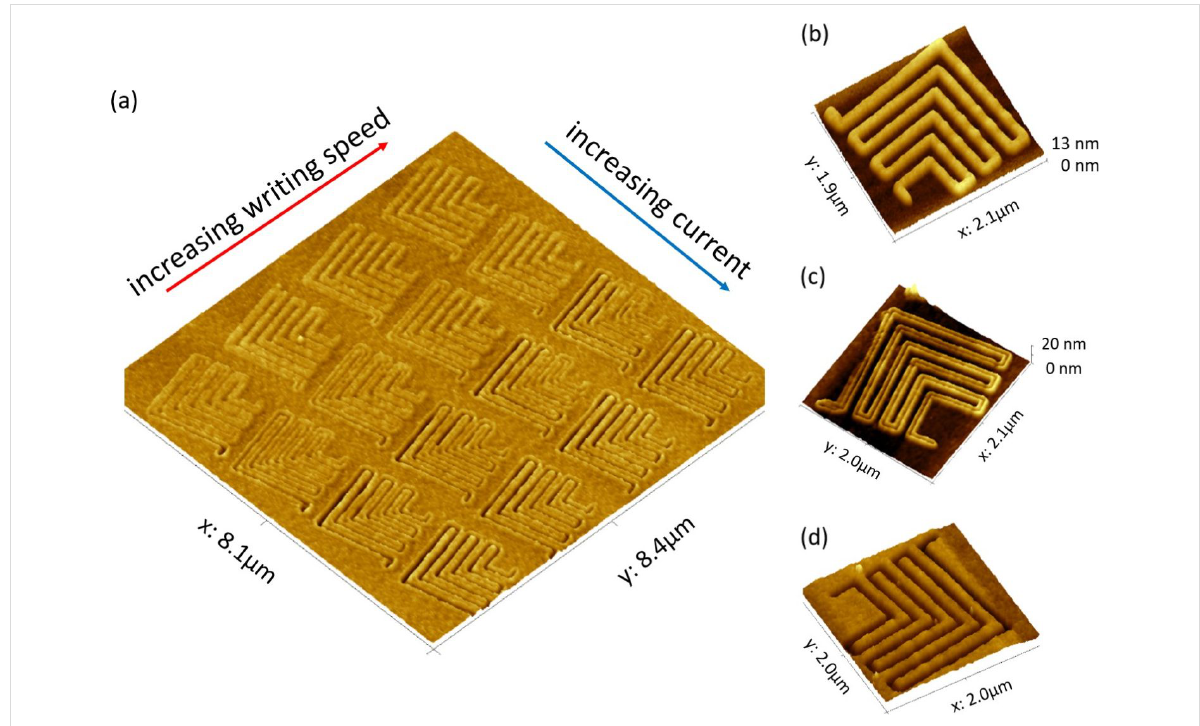
Figure 18: (a) Results of typical exposure dose test for determination of lithographic tone as a function of the exposure dose. AFM image of standard exposure dose test on resist AZ ® BARLi ® acquired directly after FE-eSPL. The dose is varied by changing the writing speed from 1 to 2.5 μ m·s − 1 (marked with red arrow) and by changing the current from 15 to 30 pA (blue arrow). (b–d) Close-up AFM image on different lithographic tones ob- tained after etching. (b) Negative tone feature, (c) intermittent tone, which is a combination of positive tone (trenches in the middle of the line) and negative tone (hills at the border of the lines), (d) positive tone